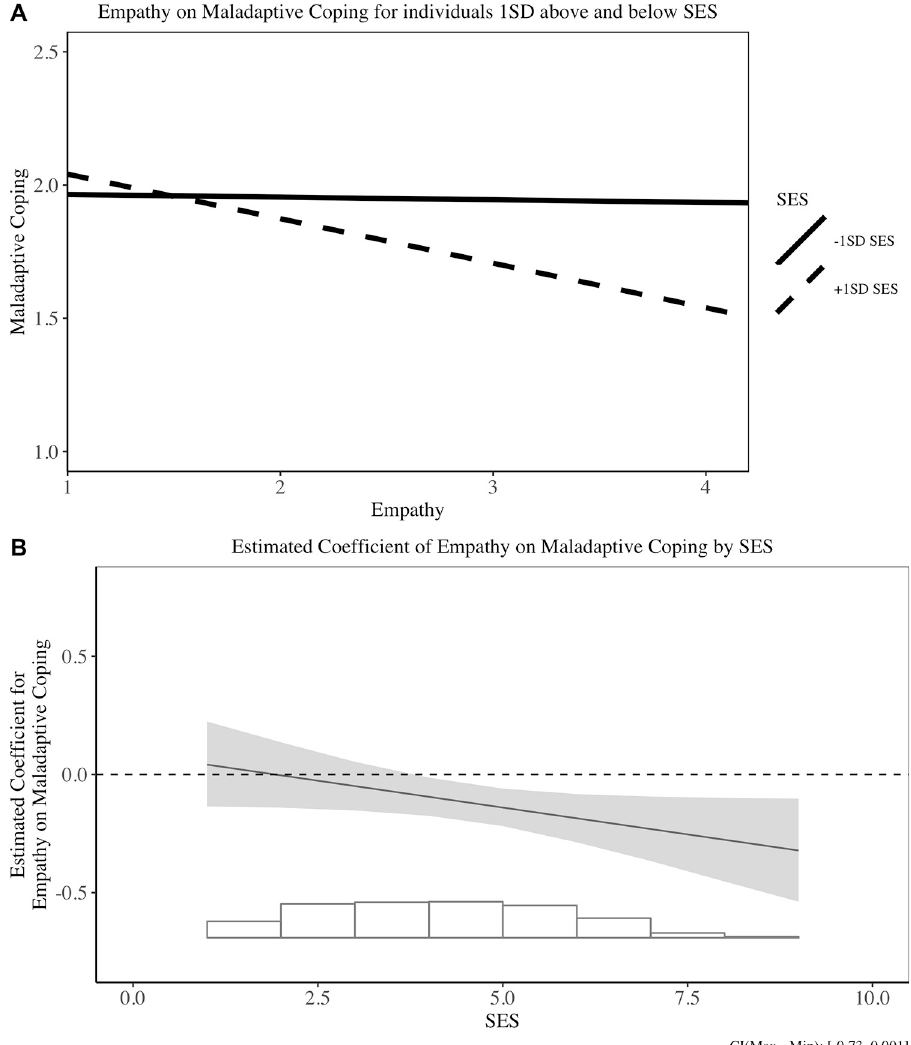
Fig 3. Relationship between empathy and maladaptive coping in Study 1. (A) Simple slope result for +/- 1SD SES individuals on maladaptive coping. (B) Estimated coefficient of empathy on maladaptive coping for different SES